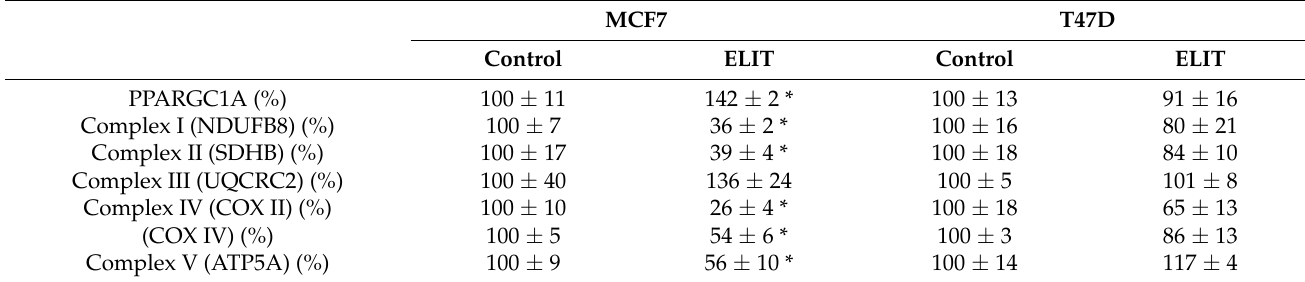
Table 4. Mitochondrial-related protein levels in MCF7 and T47D breast cancer cell lines.